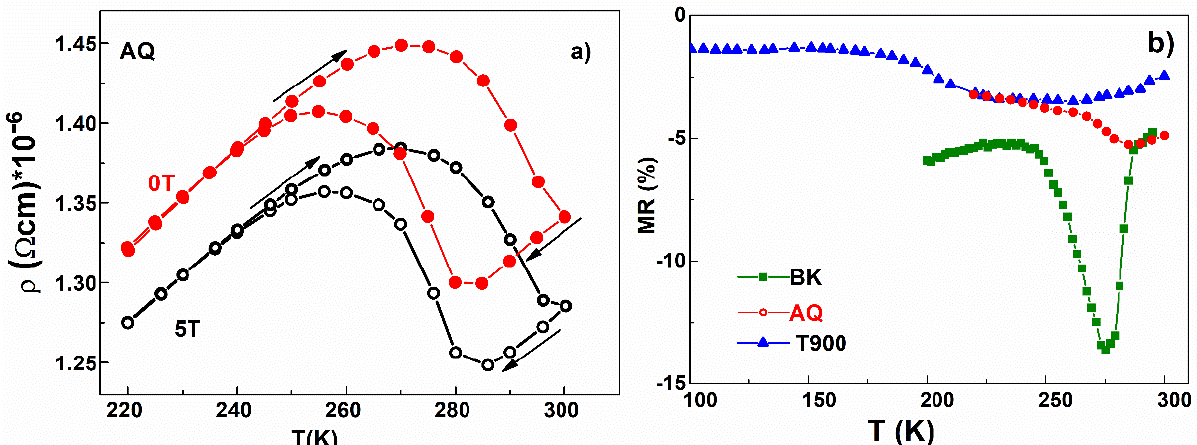
Figure 8. ( a ) Temperature dependence of resistivity in H = 0 T and H = 5 T (open symbols) for AQ ribbons; ( b ) Thermal variation in magnetoresistance in 5 T.